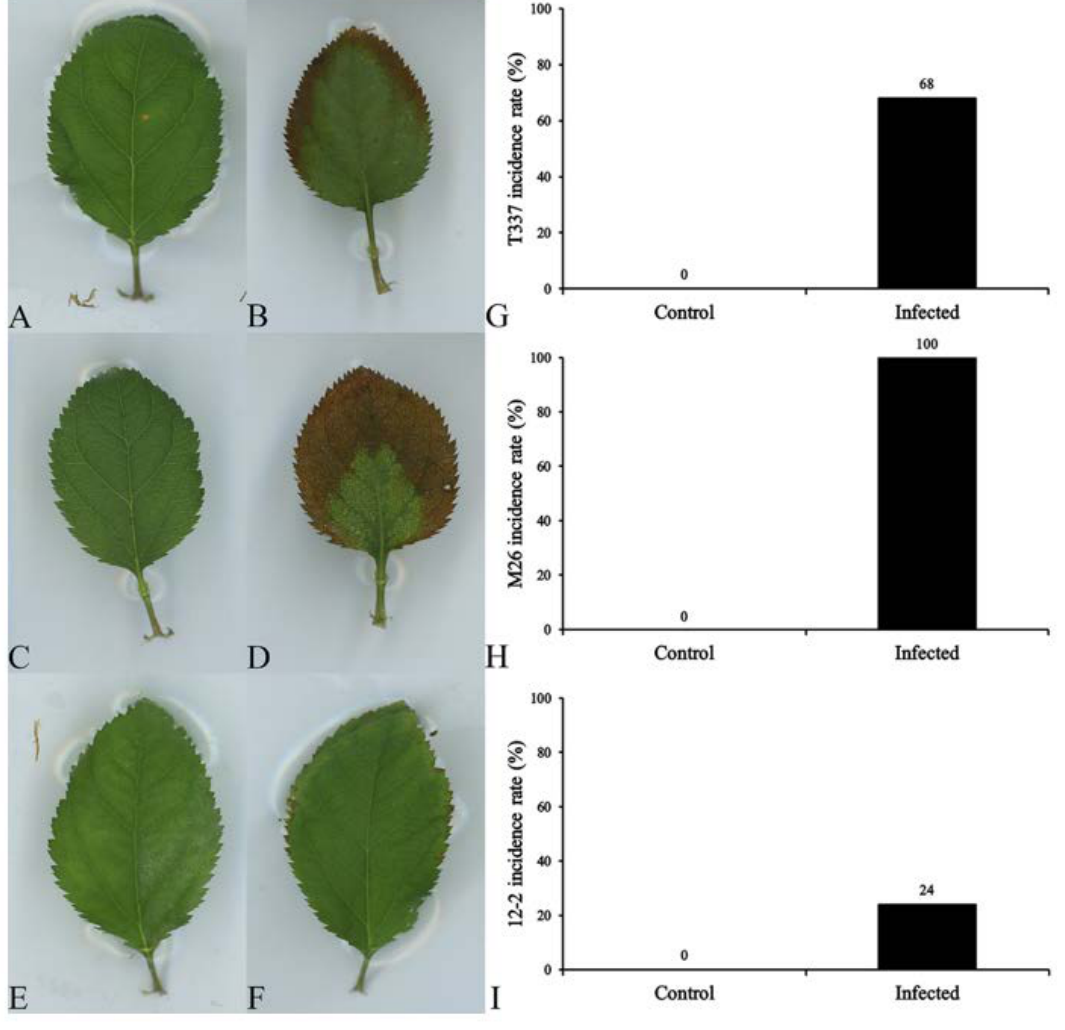
Figure 1. Effects of F. proliferatum MR5 on the three rootstocks after 7 days. ( A ) Control T337 leaves. ( B ) Infected T337 leaves. ( C ) Control M26 leaves. ( D ) Infected M26 leaves. ( E ) Control 12-2 leaves. ( F ) Infected 12-2 leaves. ( G ) T337 incidence rate. ( H ) M26 incidence rate. ( I ) 12-2 incidence rate. Note: Scale bars in ( A – F ) are 1 cm. Table 1. The number of plants of the three rootstocks in each grade 7 days after MR5 infection.